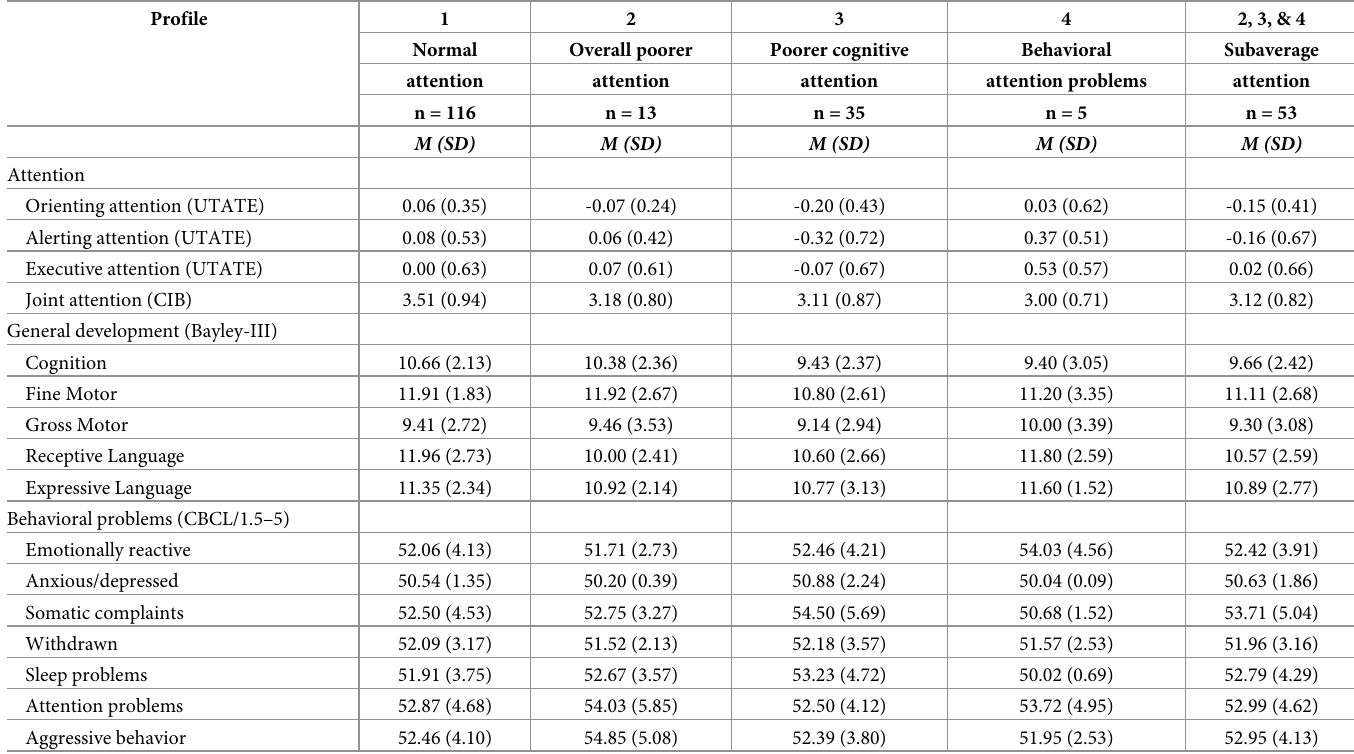
Table 6. Means and SDs of predictors at 18 and 24 months per attention profile at 6 years (N =